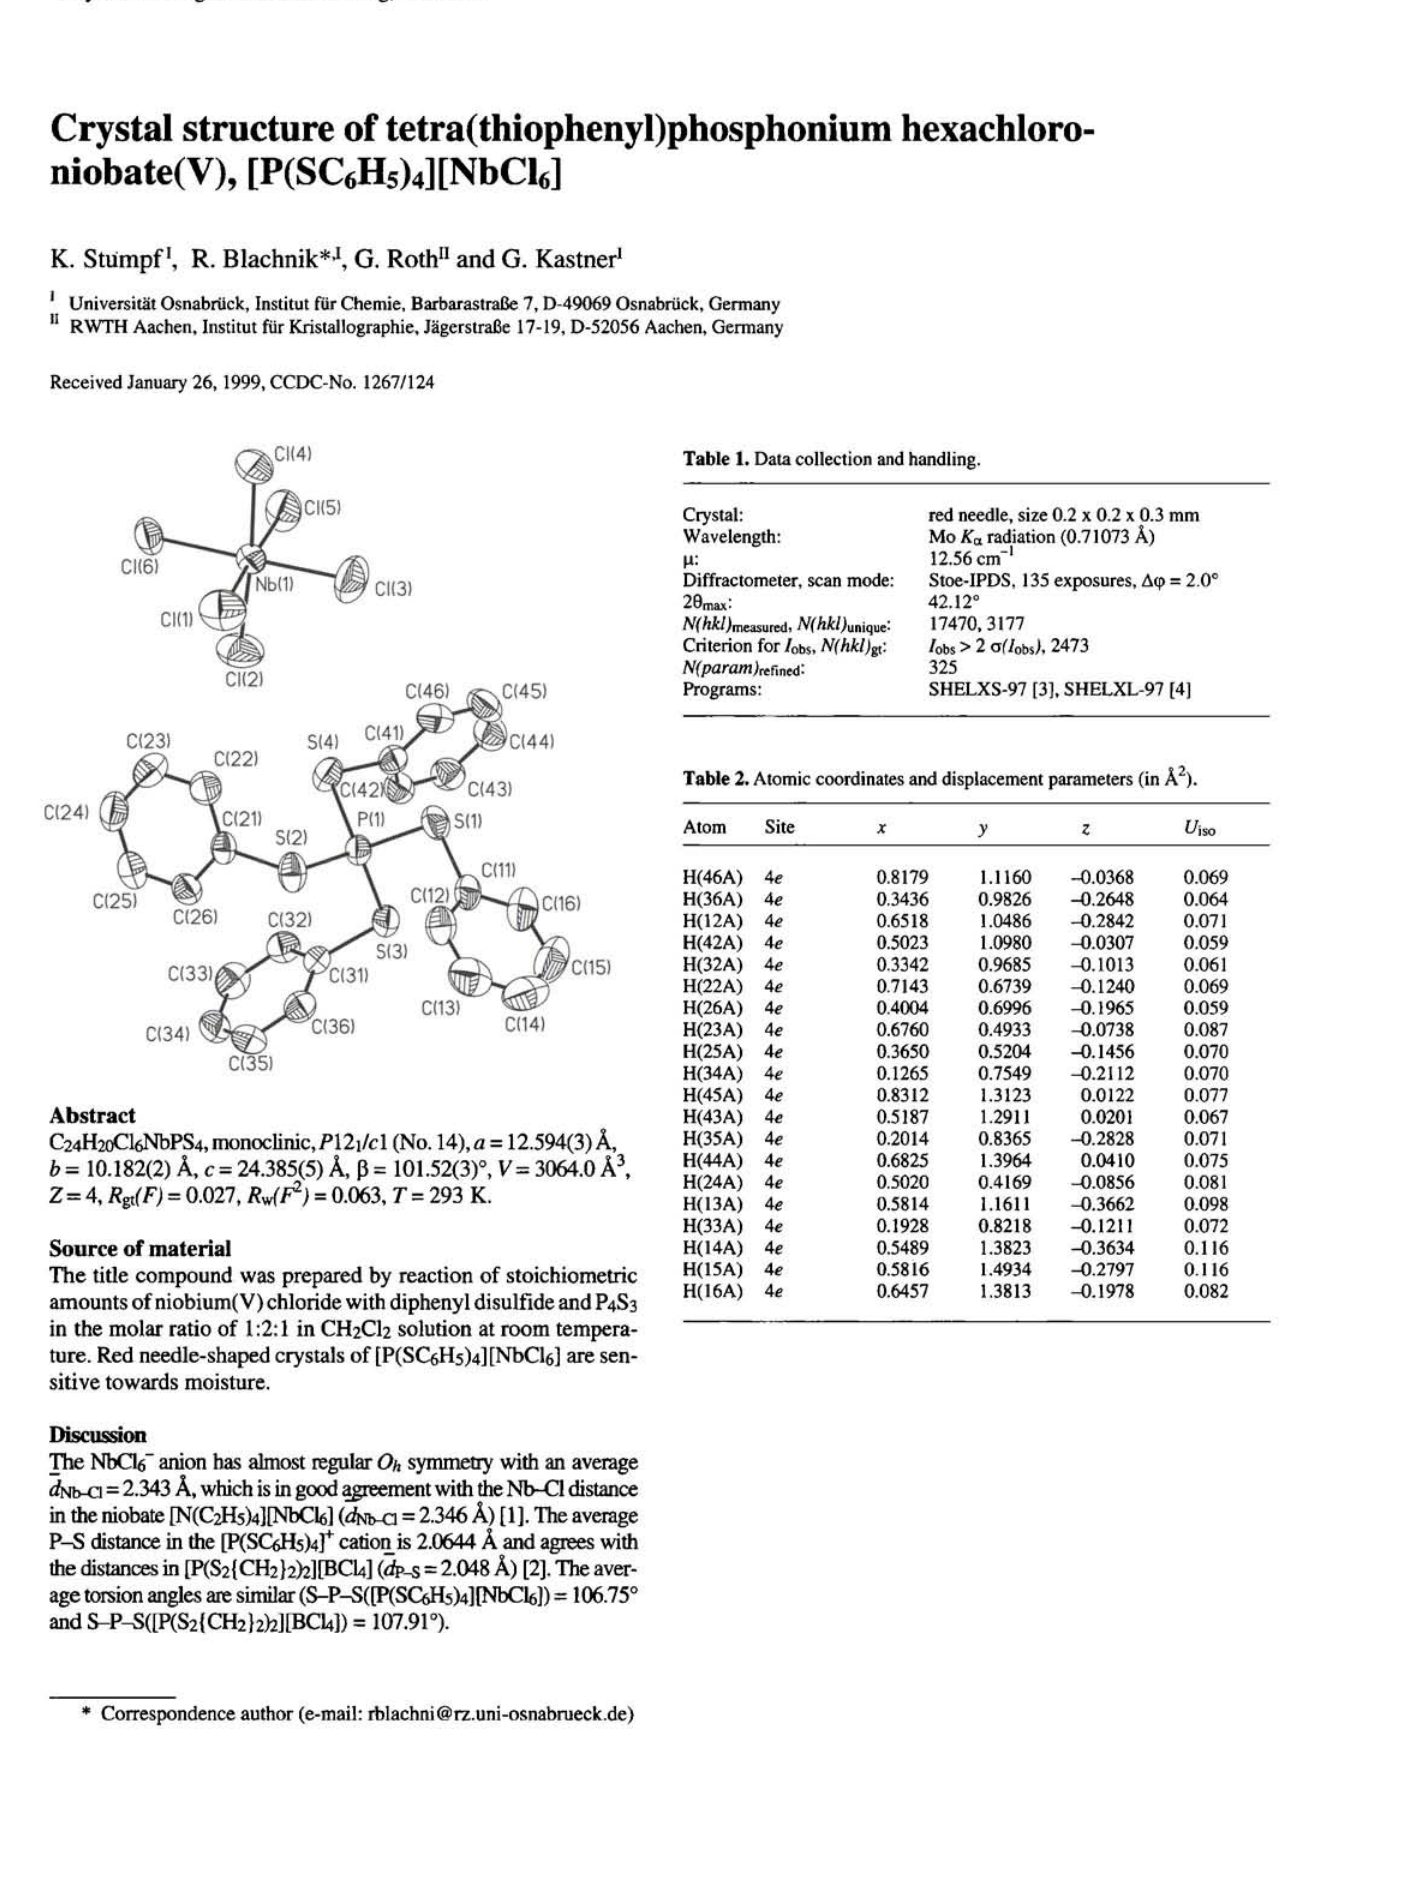
Table 1. Data collection and handling.